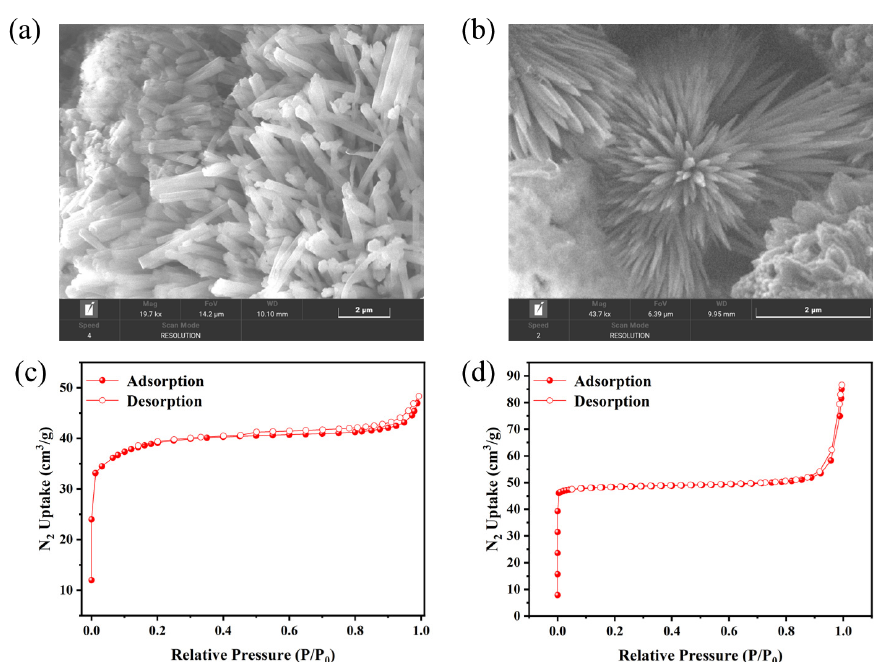
Figure 2. SEM images of JUC − 624 ( a ) and JUC − 625 ( b ). N 2 adsorption-desorption isotherms of JUC − 624 ( c ) and JUC − 625 ( d ). JUC − 624 ( c ) and JUC − 625 ( d